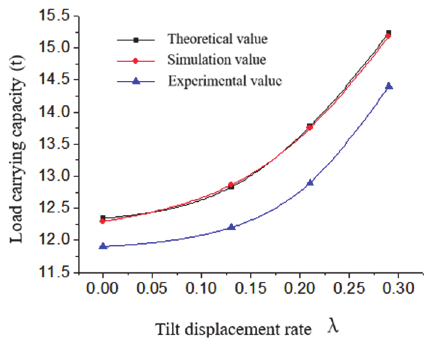
Figure 8. Relationship between load bearing force and tilt displacement